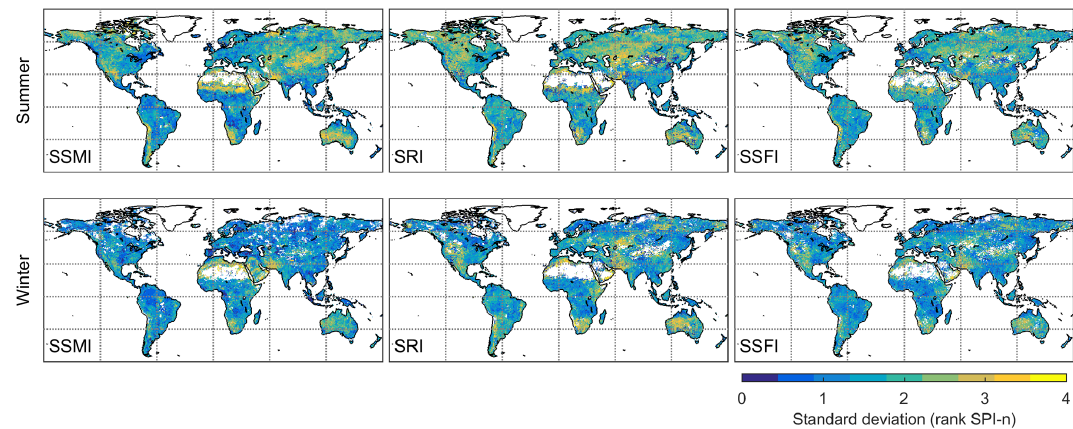
Figure 5. The standard deviation of the rank of SPI-n between the different hydrological models for summer and winter droughts in SSMI, SRI, and SSFI.